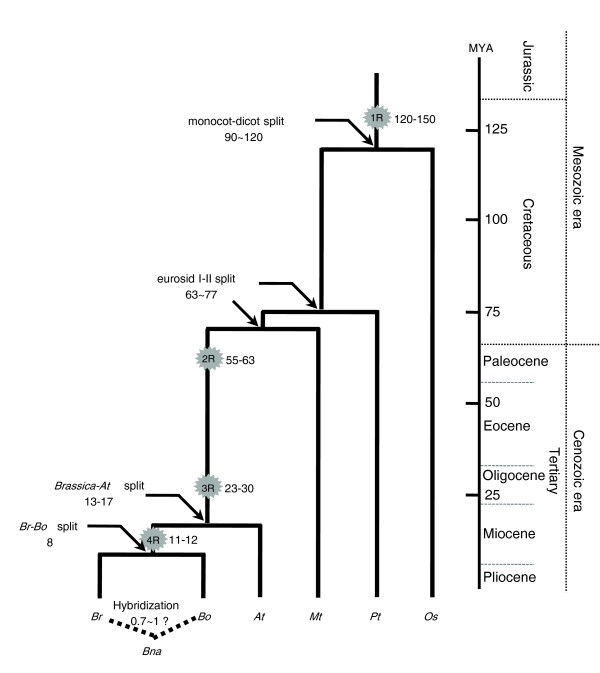
Polyploidy events in the evolution of the Brassica genome. Each star indicates a WGD (1R, 2R, and 3R) or WDT (4R) event on the branch. Estimation of dates for polyploidy and speciation events are given in million years and are based on the Ks analysis performed in this study, except for the 1R event, which was inferred from a previous report [1]. A geographic time-table is provided on the right border of the figure. At, A. thaliana; Bna, B. napus; Bo, B. oleracea; Br, B. rapa; Mt, Medicago truncatula; Os, O. sativa; Pt, Populus trichocarpa.